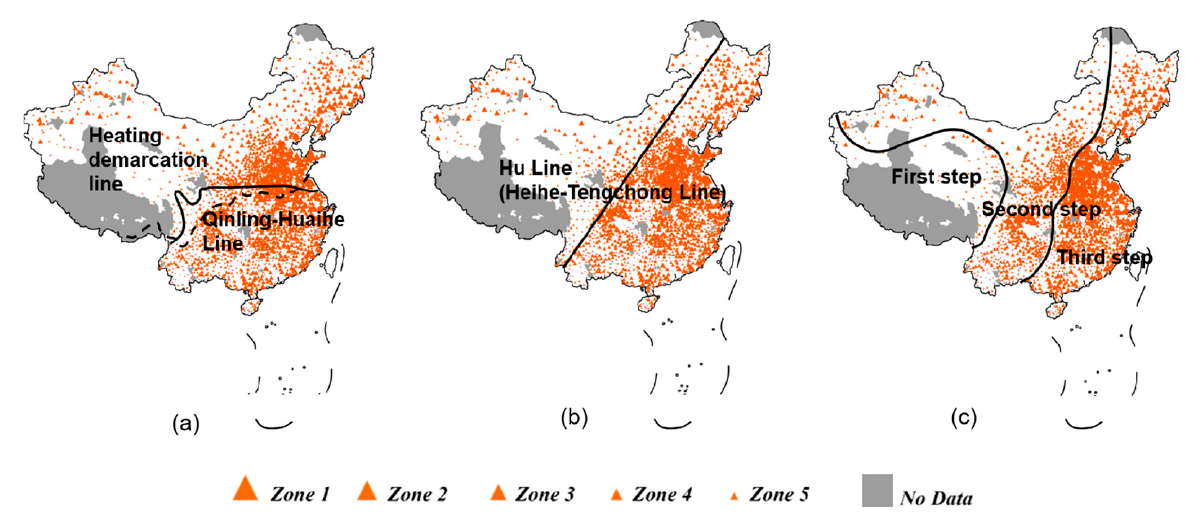
Figure 5. Comparison of 3 classical Chinese geographical zoning and carbon emission governance zones. Comparison of winter heating zone ( a ), comparison of population density zone ( b ) and comparation of geomophic zone ( c ).